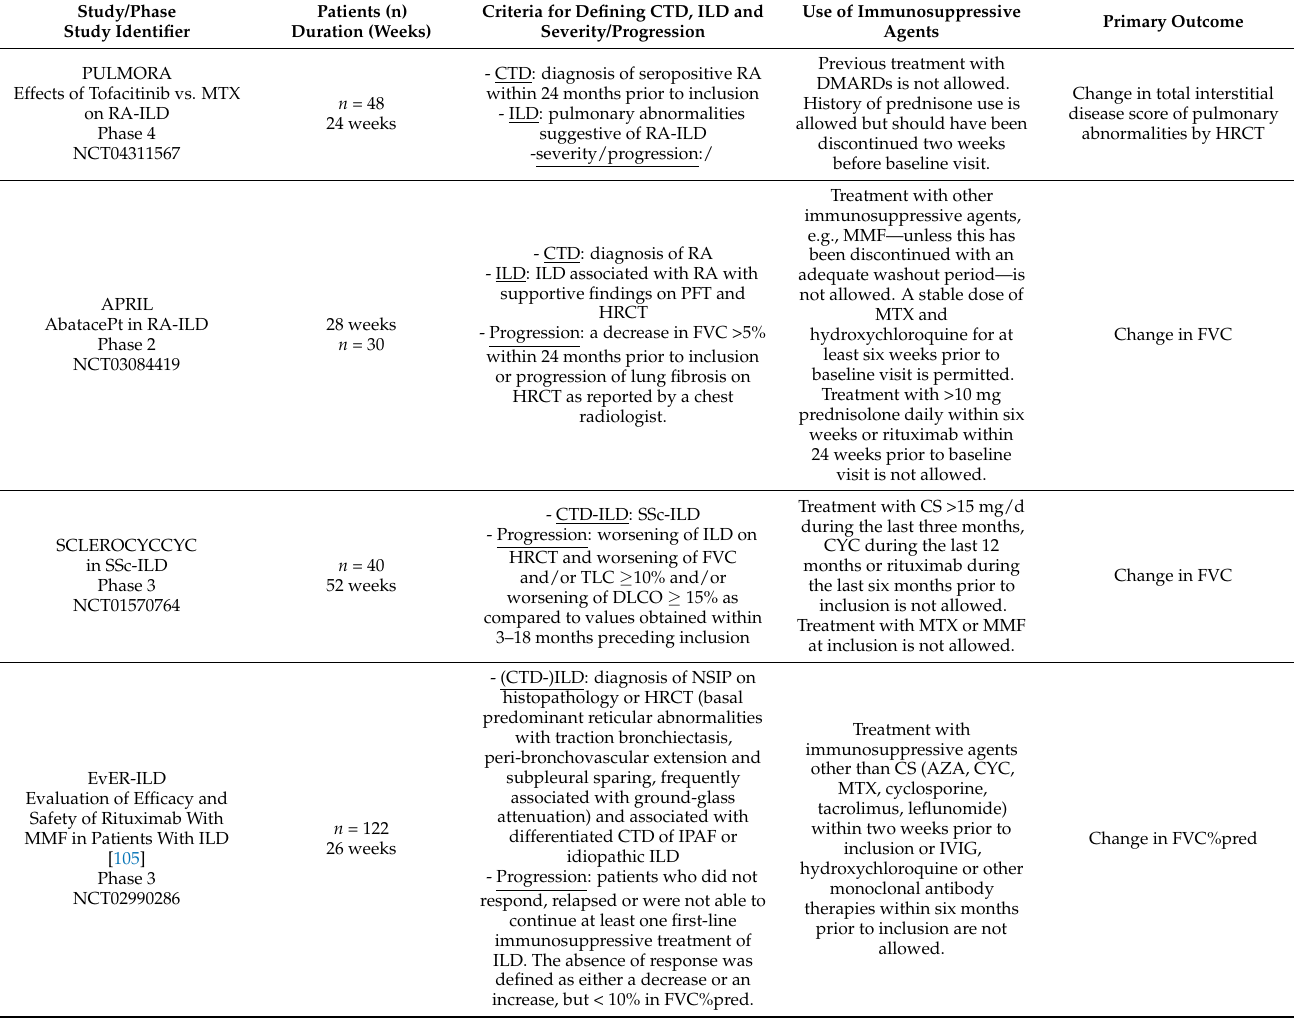
Table 2. Ongoing and unpublished randomized clinical trials with immunosuppressive agents in CTD-ILD. Study/Phase Study